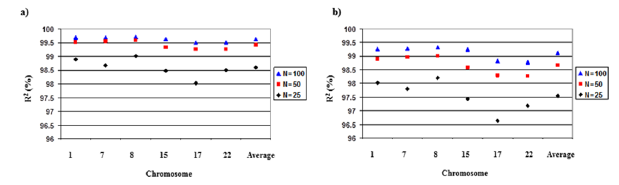
Figure 4. R 2 according to Pima Indian reference population size when a) 1% or b) 20% of genotypes were